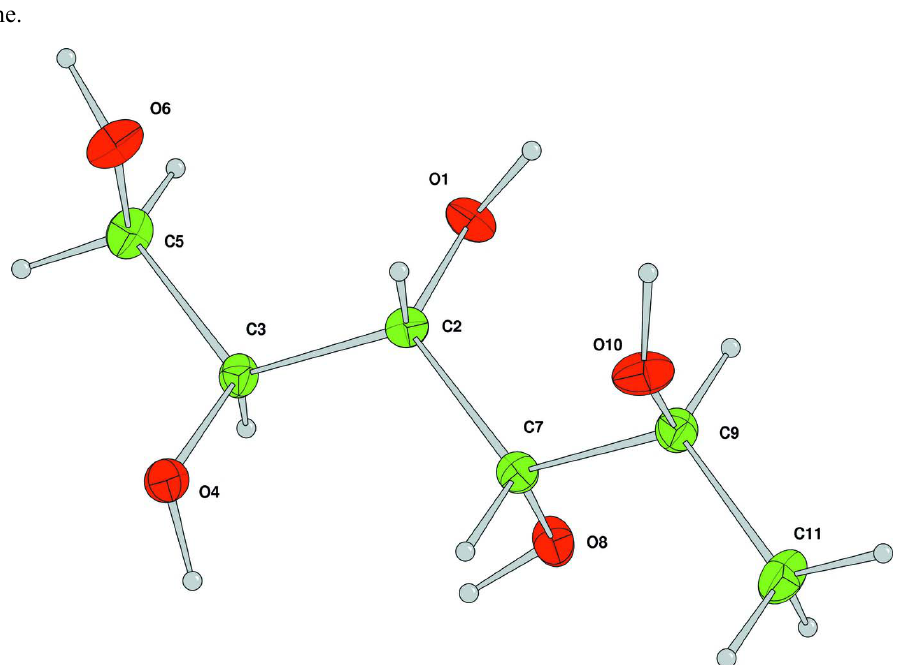
Figure 2 The title compound with displacement ellipsoids drawn at the 50% probability level. H atoms are shown as spheres of arbitary